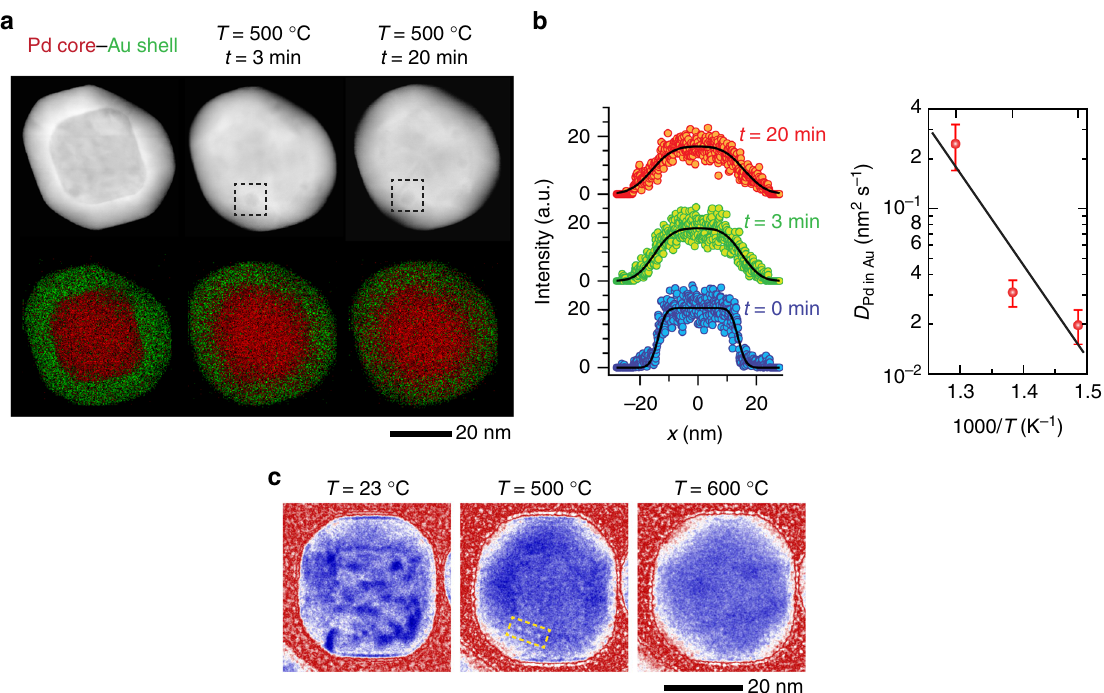
Fig. 2 Heating-induced changes in the morphology of Pd core – Au shell (Au – Pd) NPs. a In situ STEM images of the same NP after heating at 500 °C for 3 and 20 min, and their corresponding EDX maps. The dashed box highlights a void in the NP. b (Left) Diffusion pro fi les extracted from the EDX measurements presented in the panel ( a ) and their respective error-function fi ts (black curves). (Right) Diffusion coef fi cients of Pd diffusing in Au obtained from extended studies (Supplementary Fig. 8), where we followed the diffusion of Pd in these NPs as a function of temperature and time. The error bars indicate the standard deviation in the diffusion coef fi cients obtained at each temperature. An Arrhenius fi t (black line) to the averaged diffusion coef fi cients gives the activation energy of E a = 1.0 ± 0.6 eV. c In situ TEM image sequence of a NP during heating to 500 and 600